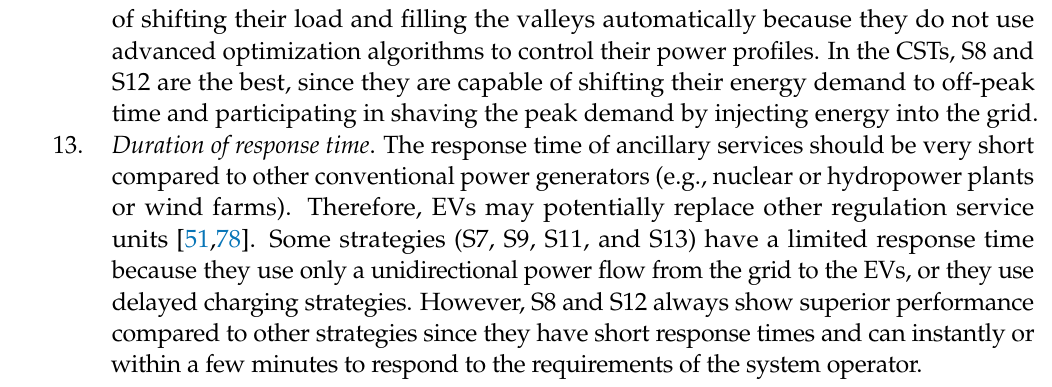
Charging Strategy